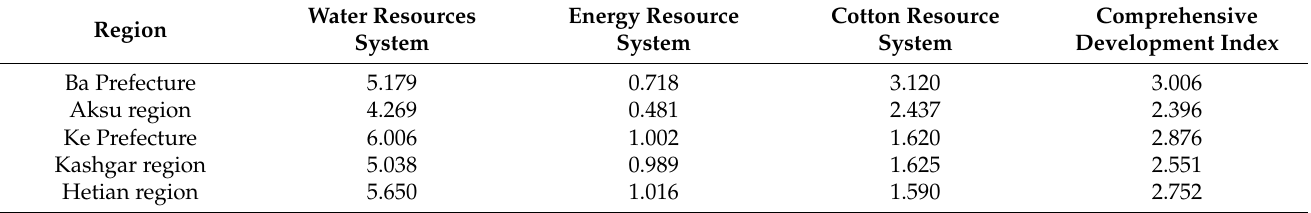
Table 4. System evaluation index of water resource-energy-cotton system in Tarim River